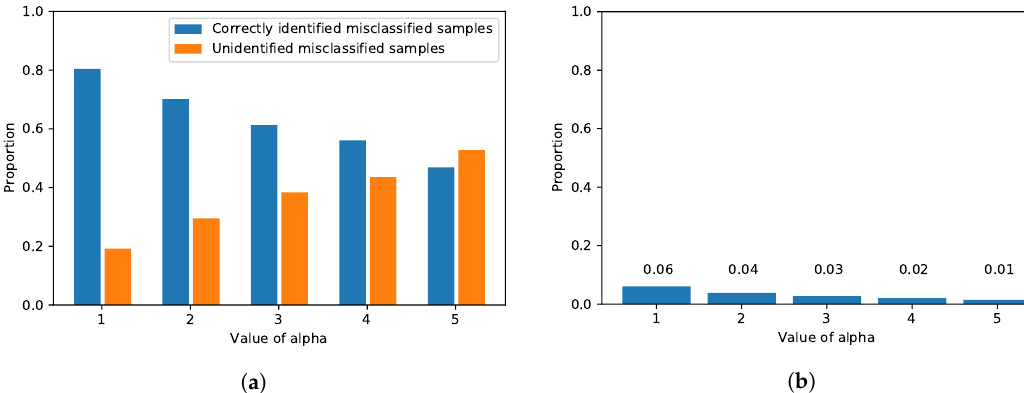
Figure 5. The detection performance of UFrame as to the MNIST test dataset is shown. ( a ) Among the samples misclassified by the ANN model, the proportions of the correctly identified samples (i.e., error flag was true) and those that were not (i.e., error flag was false) are shown in blue and orange, respectively. ( b ) Among the correctly identified samples by the ANN model, the proportion of the incorrectly identified samples (i.e., error flag was true) is shown with the corresponding value. Table 2. The exact values reported in Figure 5 when there are 10,000 test